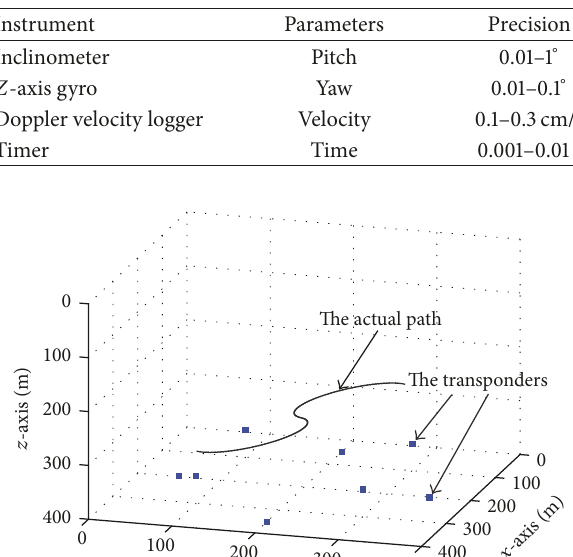
Table 1: Simulation parameters of the used instruments for under- water vehicle localization.